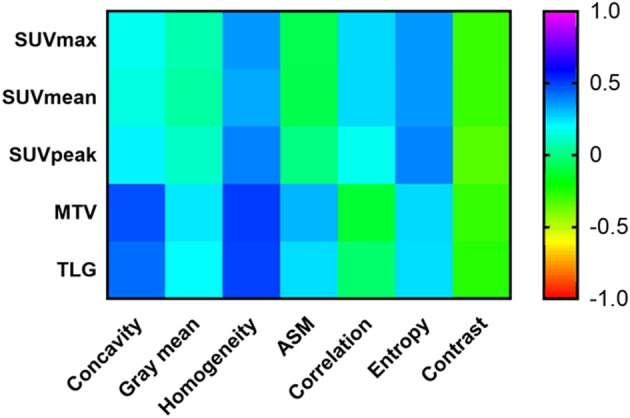
A heat map for the correlation between conventional PET parameters and the identified radiomic features extracted from PET images. PET, positron emission tomography.